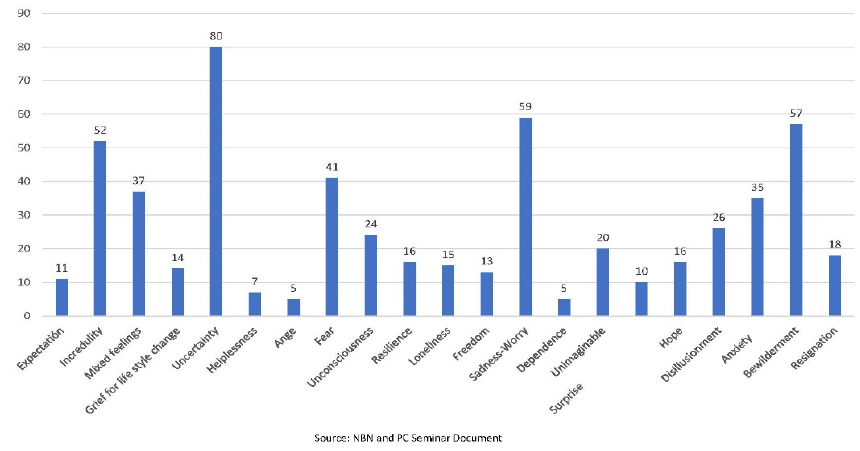
Figure 1. Feelings during the first day of confinement.